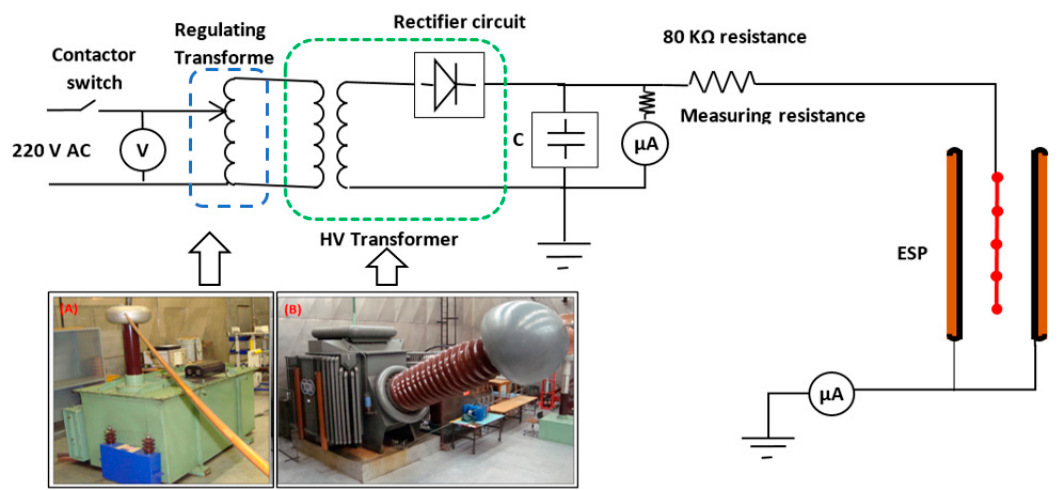
Figure 11. Set-up of an experiment scheme diagram for measuring the corona of WDESP; Laboratory of High Voltage Engineering at Czech Technical University in Prague, Czech Republic.